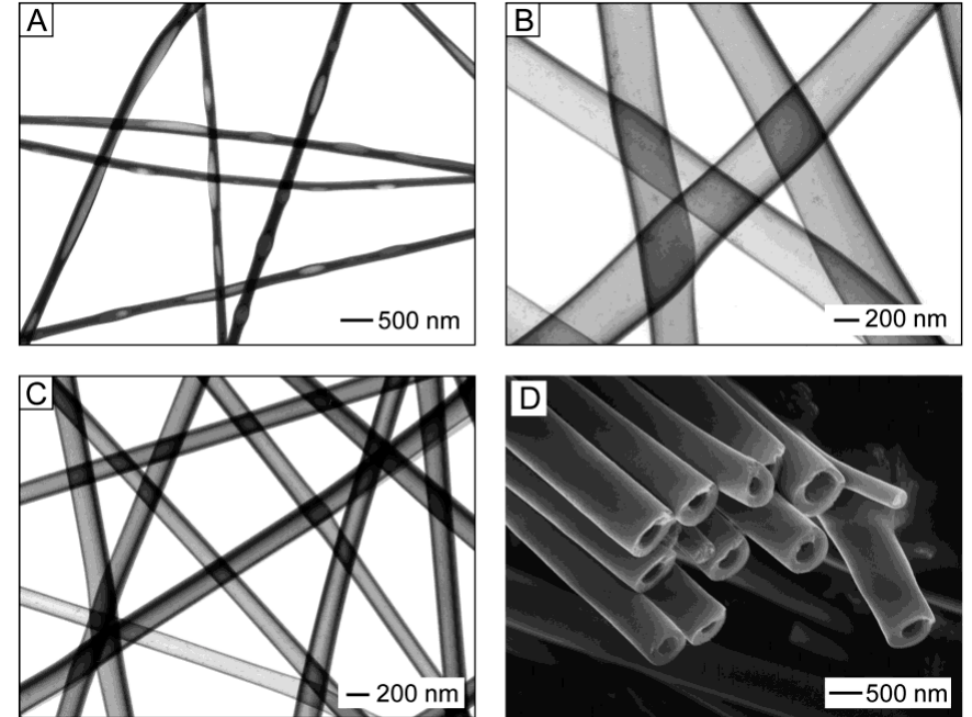
Figure 8. ( A – C ) TEM images of TiO 2 /PVP hollow fibers fabricated by electrospinning with various injection rates for the oil phase and different voltages: ( A ) 0.03 and ( B ) 0.3 mL/h under a voltage of 12 kV; and ( C ) 0.1 mL/h and 16 kV. The sheath liquid was an ethanol solution that contained both Ti(OiPr) 4 (0.3 g/mL) and PVP (0.03 g/mL). ( D ) SEM image of TiO 2 /PVP hollow fibers prepared by electrospinning a PVP solution (in ethanol, 0.03 g/mL) that contained 0.5 g/mL of Ti(OiPr) 4 . Reprinted with permission from [128]. Copyright 2004 ACS.